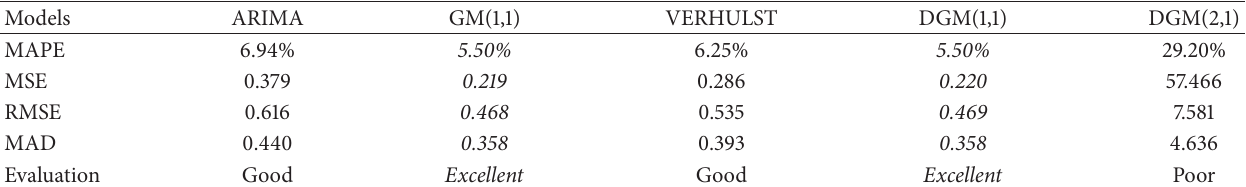
Table 8: Evaluating models with CPI forecasting errors.